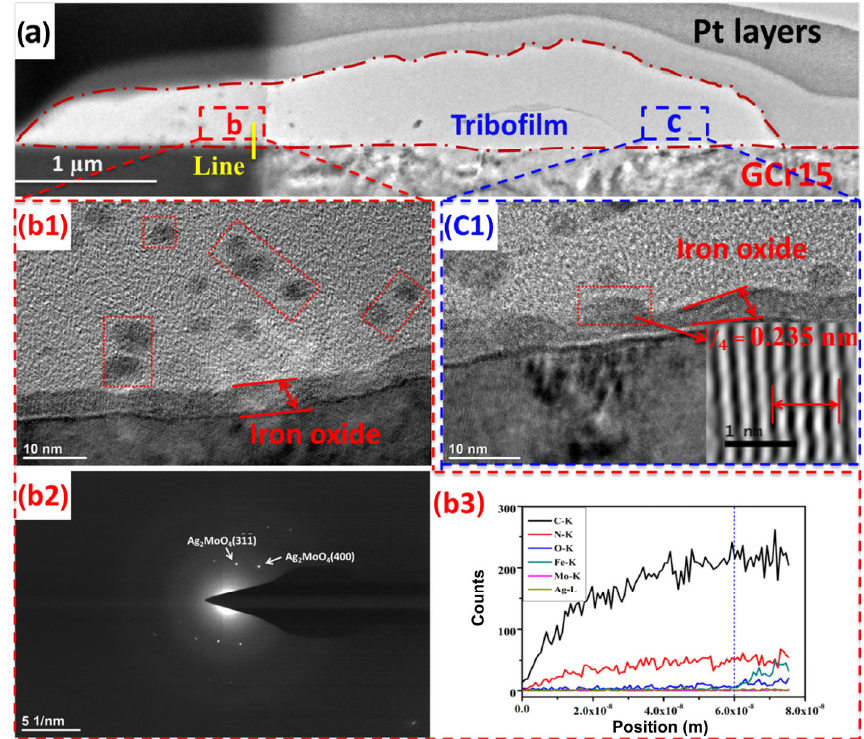
Fig. 9 (a) TEM image of the cross-section of tribofilm formed on the steel surface at 200 °C, (b1) high-magnification TEM images of zone b, (b2) the selected area electron di ff raction (SAED) of zone b, (b3) EDXS line scans across zone b with a yellow line, and (c1) high-magnification TEM images of zone